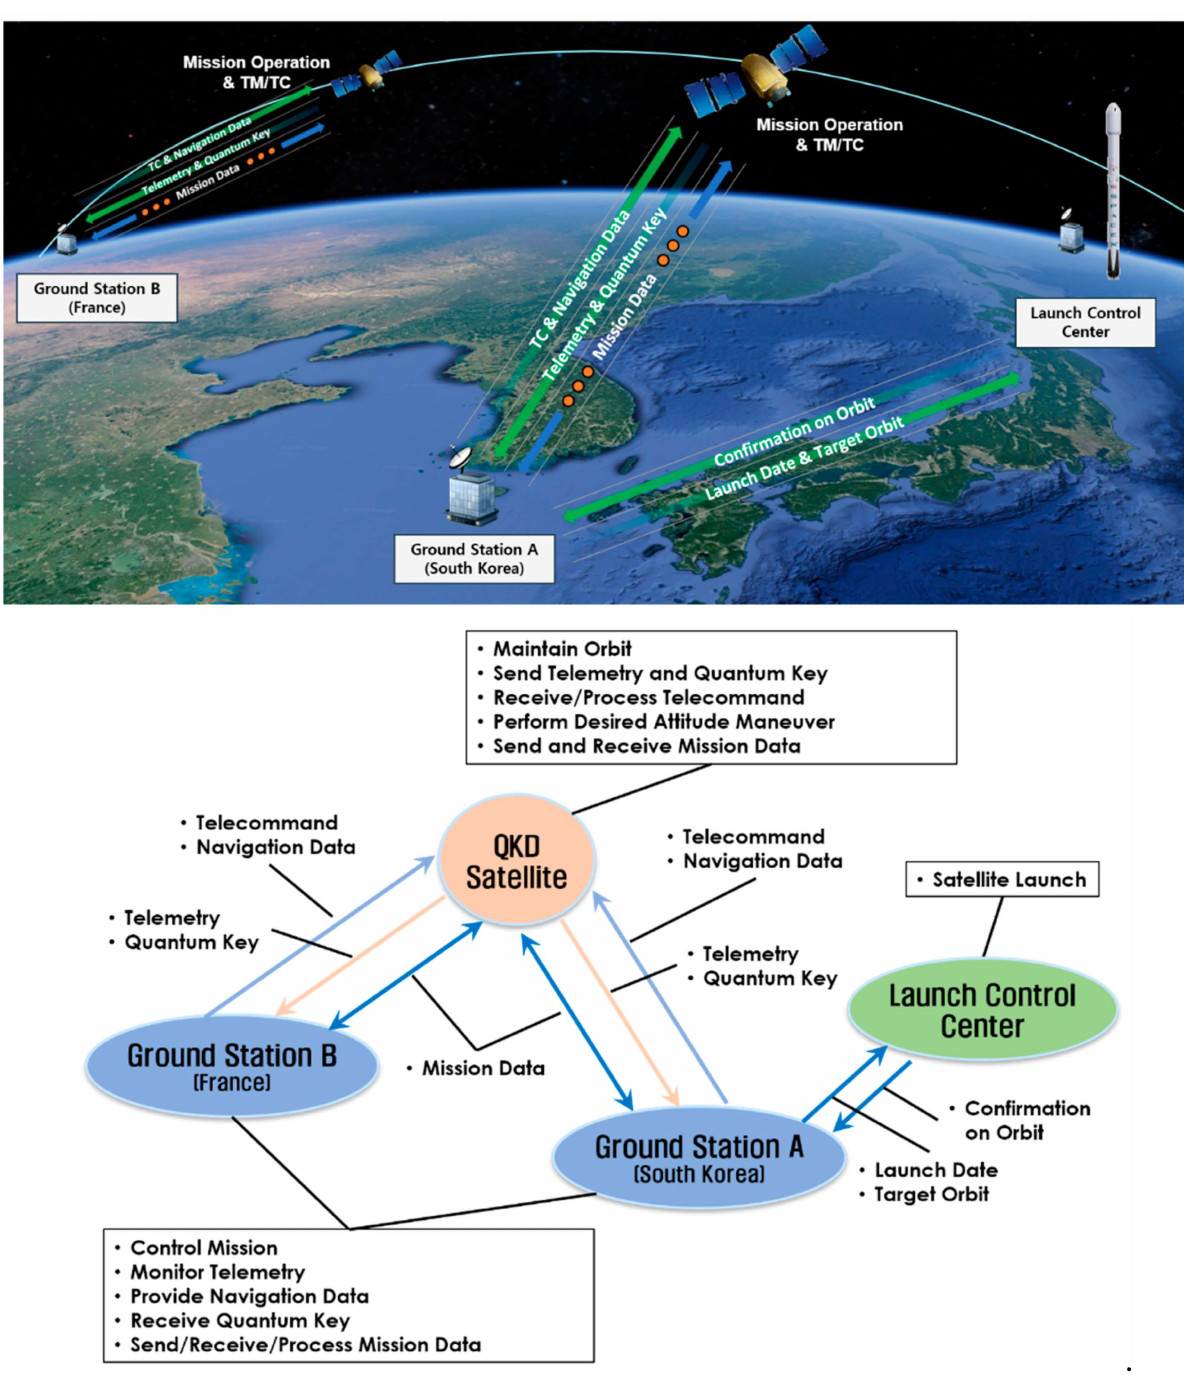
Figure 5. OV-1 ( up ) and OV-2 ( down